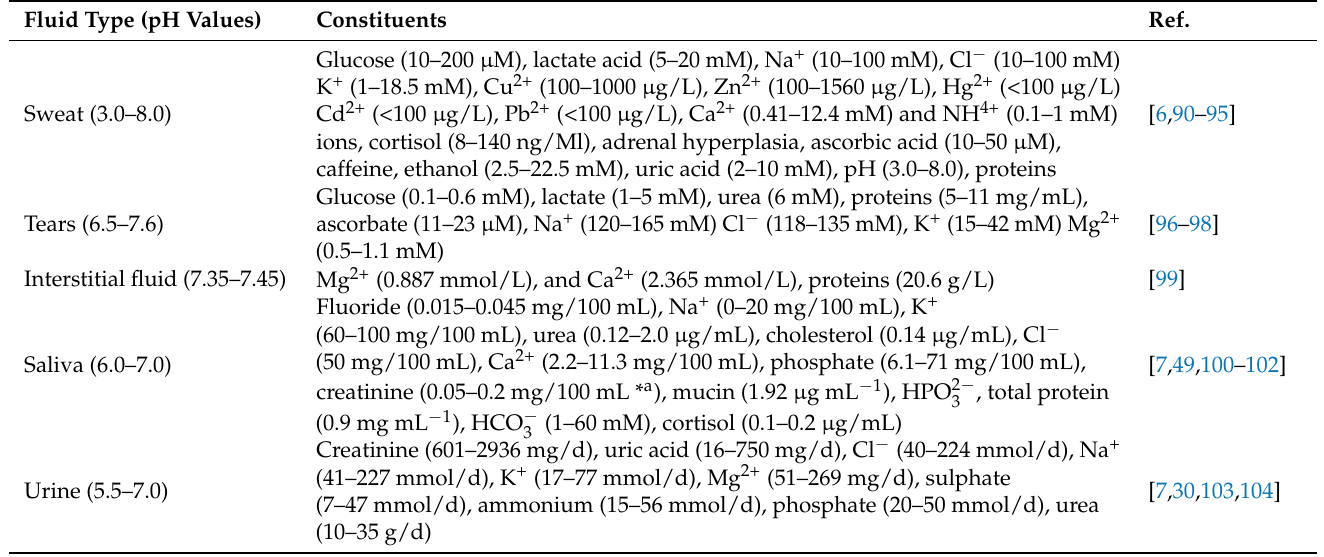
Table 2. Details of constituents and pH values of different biofluids.